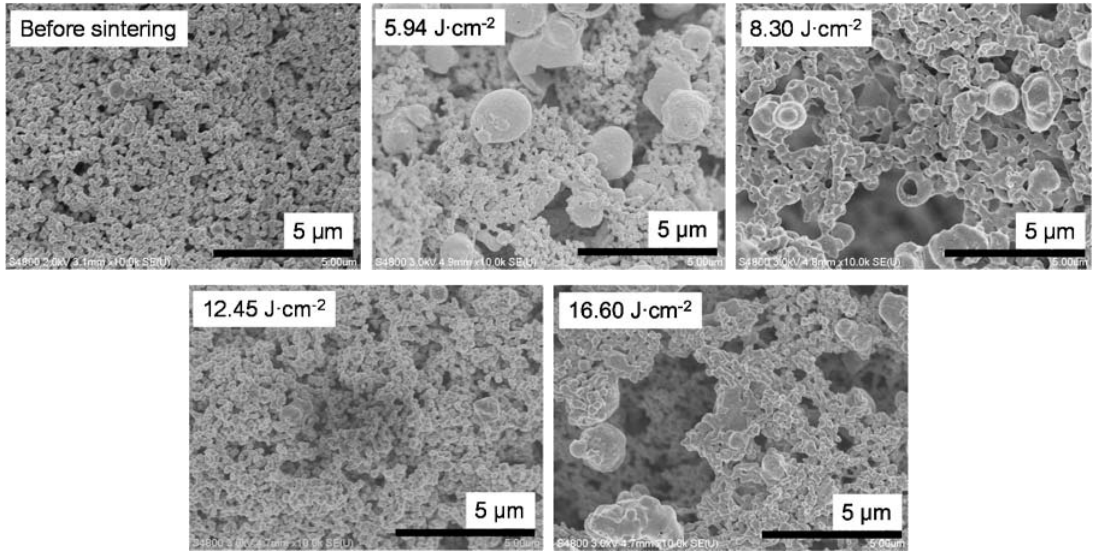
Figure 6. Scanning electron microscopy images of films prepared by using vehicle 2 before and after intense pulsed light sintering with different irradiation conditions.